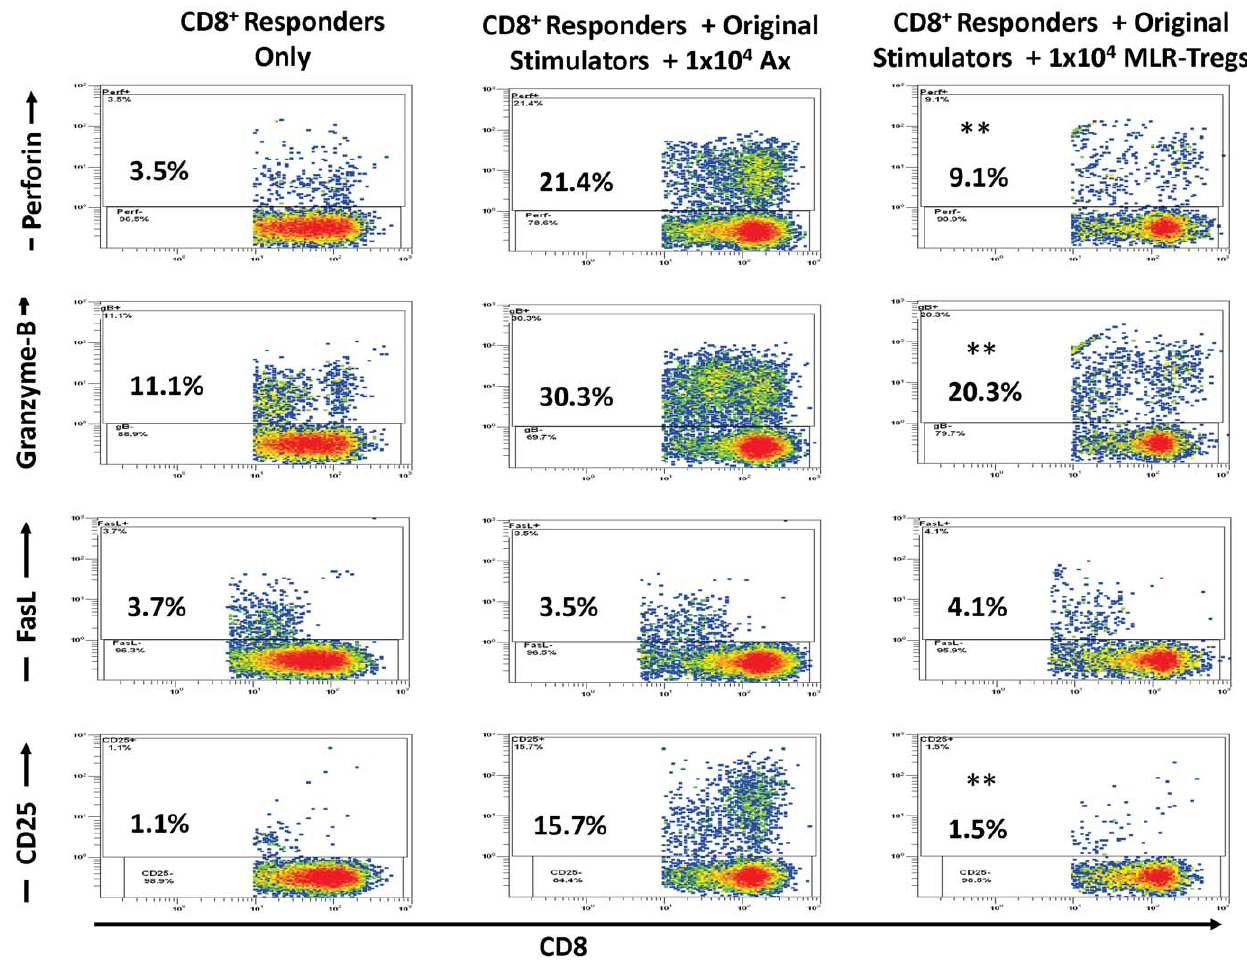
Figure 9. MLR-Tregs inhibit the expression of perforin, granzyme B and CD25 on responding CD8 + cells. 5 6 10 4 PKH26 labeled purified responder CD8 cells were cultured with the original stimulators (1 6 10 5 ) used in generating MLR-Tregs, in the presence of 1 6 10 4 autologous modulator MLR-Tregs (right) vs. autologous modulator controls (Ax; middle). After 7 days in culture, the expression of intracellular Perforin-A, Granzyme-B, and membrane CD25 was assessed by flow cytometry. The CD8 + responder cells were gated and the PKH26 high non-proliferating and PKH26-diluted proliferating cells were analyzed. It was observed that the irradiated stimulators and Ax died off by day 7 (not shown); even the few that remained were gated out on CFSE vs. CD8 density-plot during the analysis. Note that there was a profound inhibition of both proliferation (PKH26 dilution) and expression of Perforin-A, Granzyme-B and CD25 by MLR-Tregs. This experiment is representative of 4 similar ones. (**=p , 0.01;